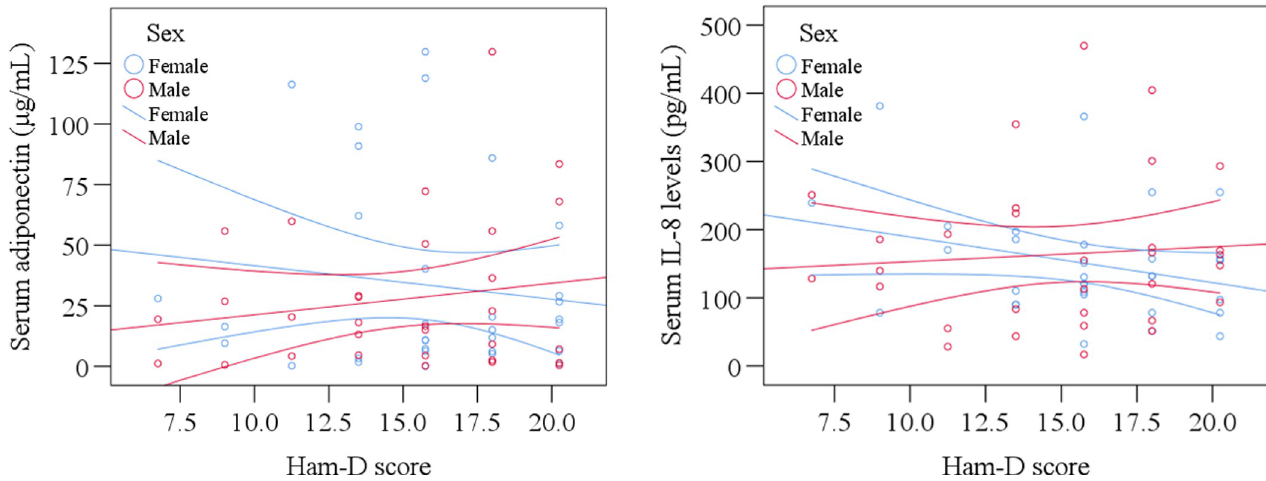
Fig 2. Scatter plot graphs are showing sex-specific associations of altered adiponectin and interleukin-8 with severity scores in MDD patients.